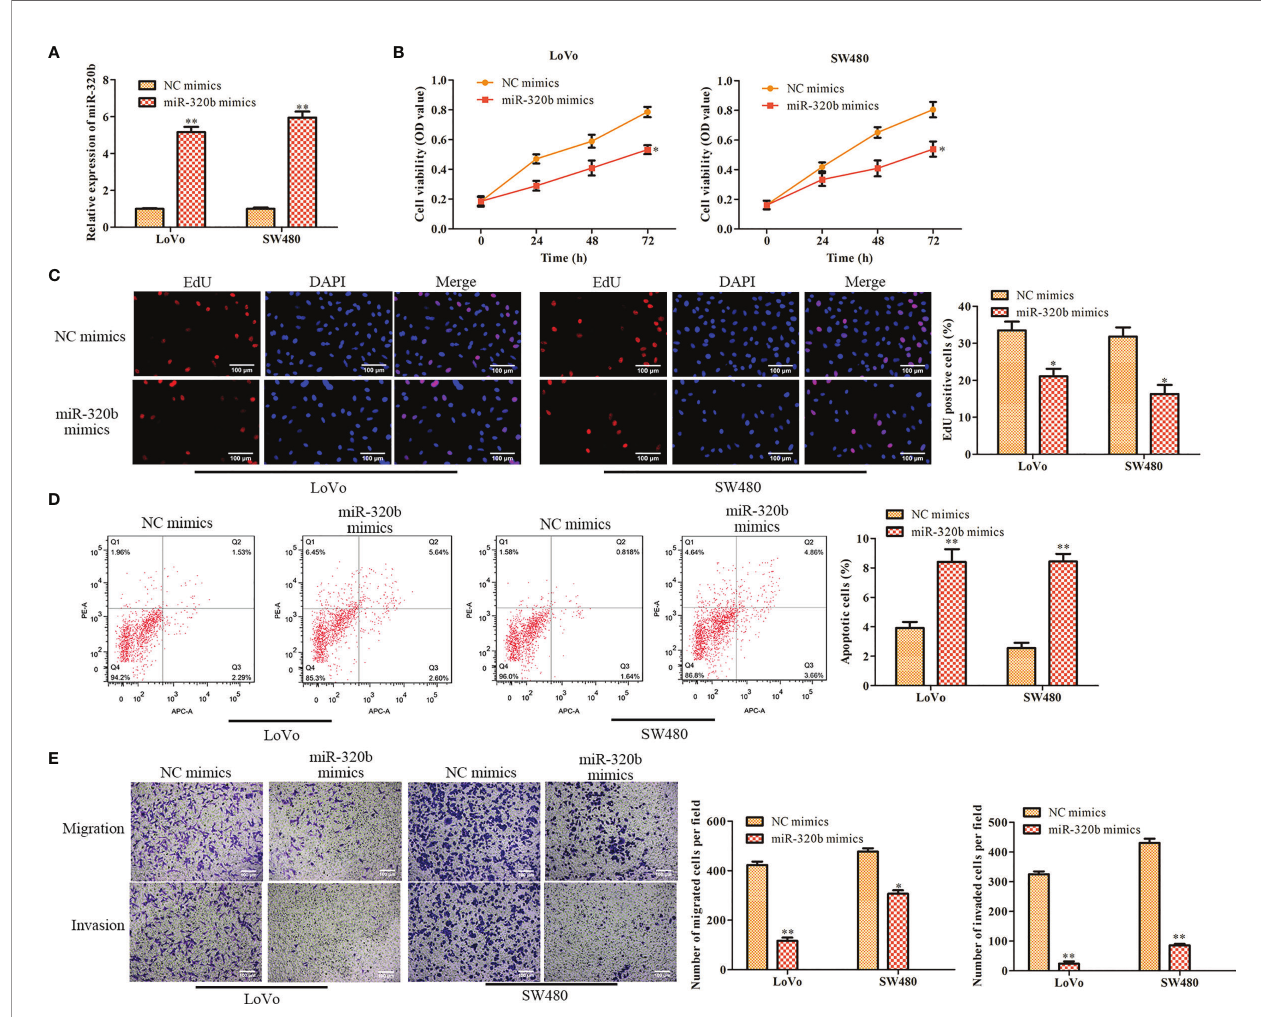
FIGURE 5 | MiR-320b represses proliferation and stimulates apoptosis of CRC cells. (A) The relative expression of miR-320b was determined by qRT-PCR in LoVo and SW480 cells. (B) The cell viability was determined using CCK-8 assay in LoVo and SW480 cells. (C) The cell proliferation was determined using EdU assay in LoVo and SW480. (D) The cell apoptosis was determined using fl ow cytometry assay in LoVo and SW480 cells. (E) The cell migration and invasion were determined using transwell assay in LoVo and SW480 cells. * P < 0.05, ** P < 0.01 vs . NC